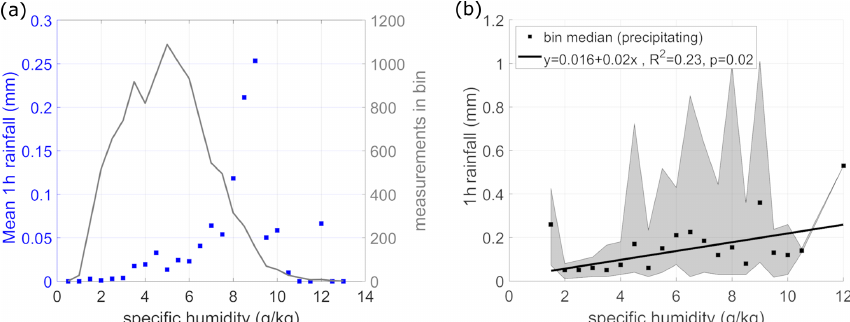
Figure 11. (a) Mean of rainfall (blue squares) accumulated in 1h (including both precipitating and non-precipitating cases), as a function of specific humidity measured at the beginning of the hour. The number of data points is shown again by a grey line. (b) Median precipitation accumulated in single wet hours as a function of specific humidity measured at the beginning of the hour. A least-squares regression weighed with the number of observations in each bin is fitted to the bin median data, and the regression equation, adjusted R 2 , and p value for the fit are shown in the legend. One exceptionally high precipitation outlier was omitted from both